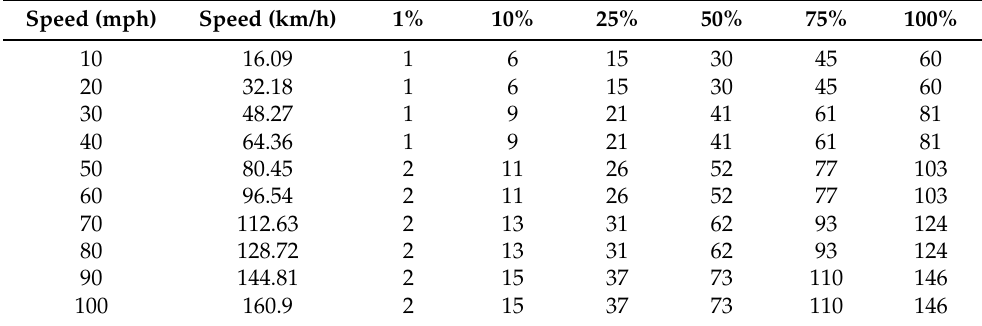
Table 8. Advanced Driver Assistance Systems (ADAS)/Dedicated Short-Range Communication (DSRC) percentage losses.